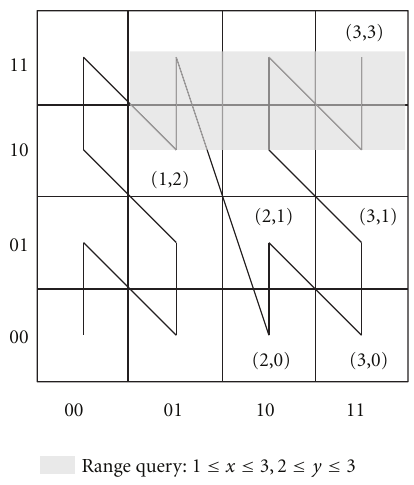
Figure 4: Results for a range query over a one-dimensional z